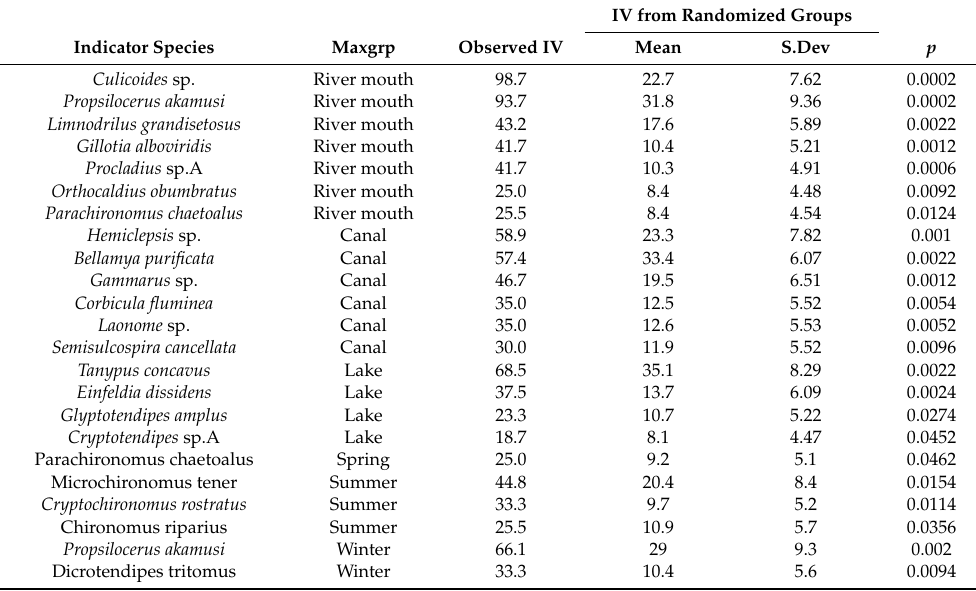
Table A4. Indicator species among regions and seasons.